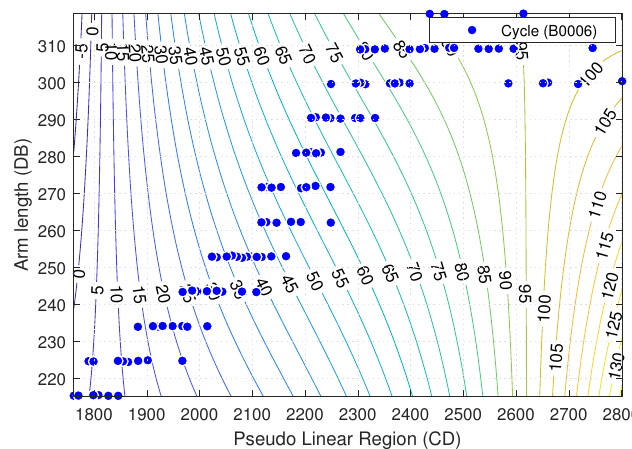
Figure 7. Contour plot showing the effect of cycle number on Arm Length and Pseudo Linear Region at 297.15 K.